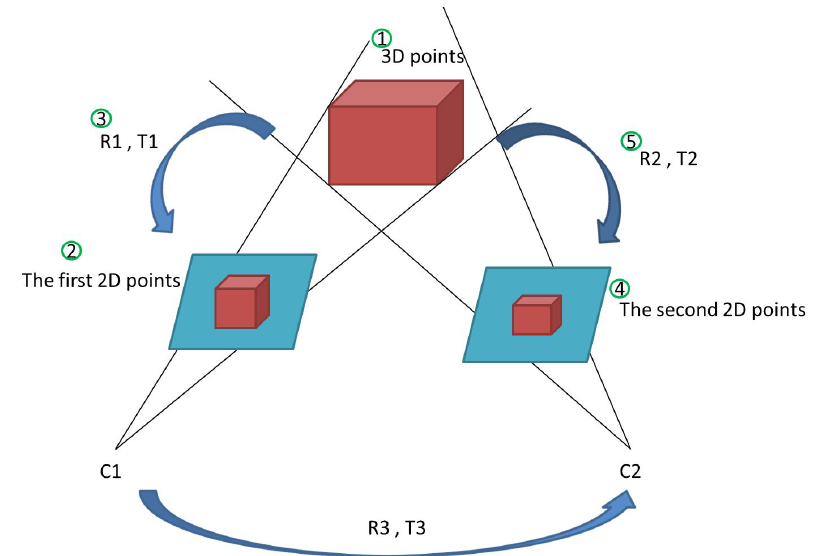
Figure 8. The computation of relative camera position and robot motion using the efficient perspective-n-point (EPnP)